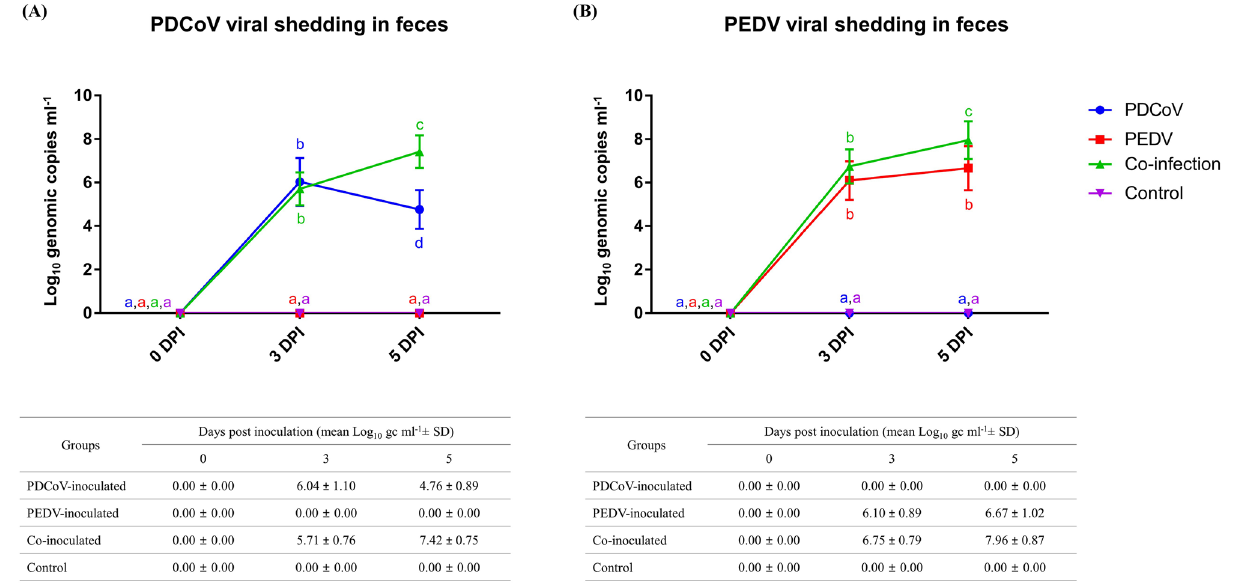
Figure 2. PDCoV ( A ) and PEDV ( B ) shedding in rectal swabs at 0-, 3- and 5-days post-inoculation (dpi). Blue circles, red squares, green triangles, and purple triangles represent PDCoV-inoculated, PEDV-inoculated, co-inoculated, and control groups. Different lower-case letters indicate significant differences between each group and each dpi ( p < 0.05). Values of mean ± standard deviation (SD) of each group, and each dpi are presented in a table under the